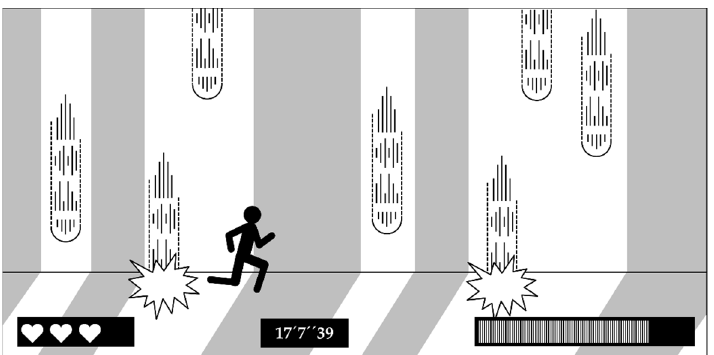
Figure 1. Mockup of the player’s screen while playing the example of a game that fails to present a dynamic analog dilemma. The screen would scroll as the player moves. The mockup shows the human figure controlled by the player, safe zones in gray, dangerous zones in white, falling objects, and three guide-user interface elements.